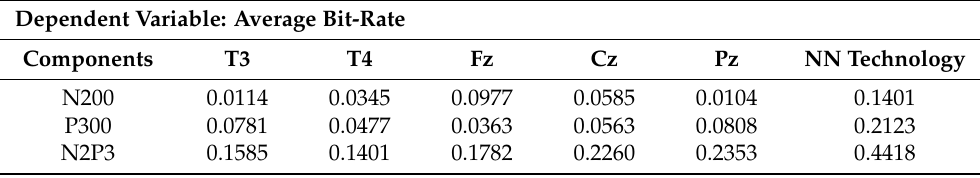
Table 13. Comparison of the bit-rate of three ERP components (N2P3, P300, and N200). Dependent Variable: Average Bit-Rate